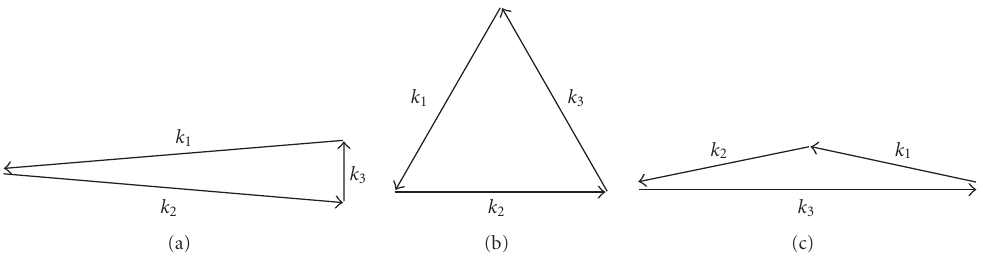
Figure 1: Triangle types contributing to the bispectrum corresponding to “squeezed” or local configurations with k 3 (cid:5) k 1 , k 2 (a), equilateral configurations with k 3 ≈ k 1 ≈ k 2 (b), and flattened configurations with k 3 ≈ k 1 + k 2